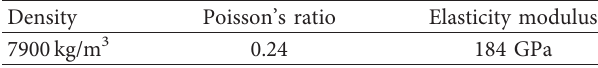
Figure 10: FE mesh of the cover. Table 5: Material properties of the aeroengine test rig cover.